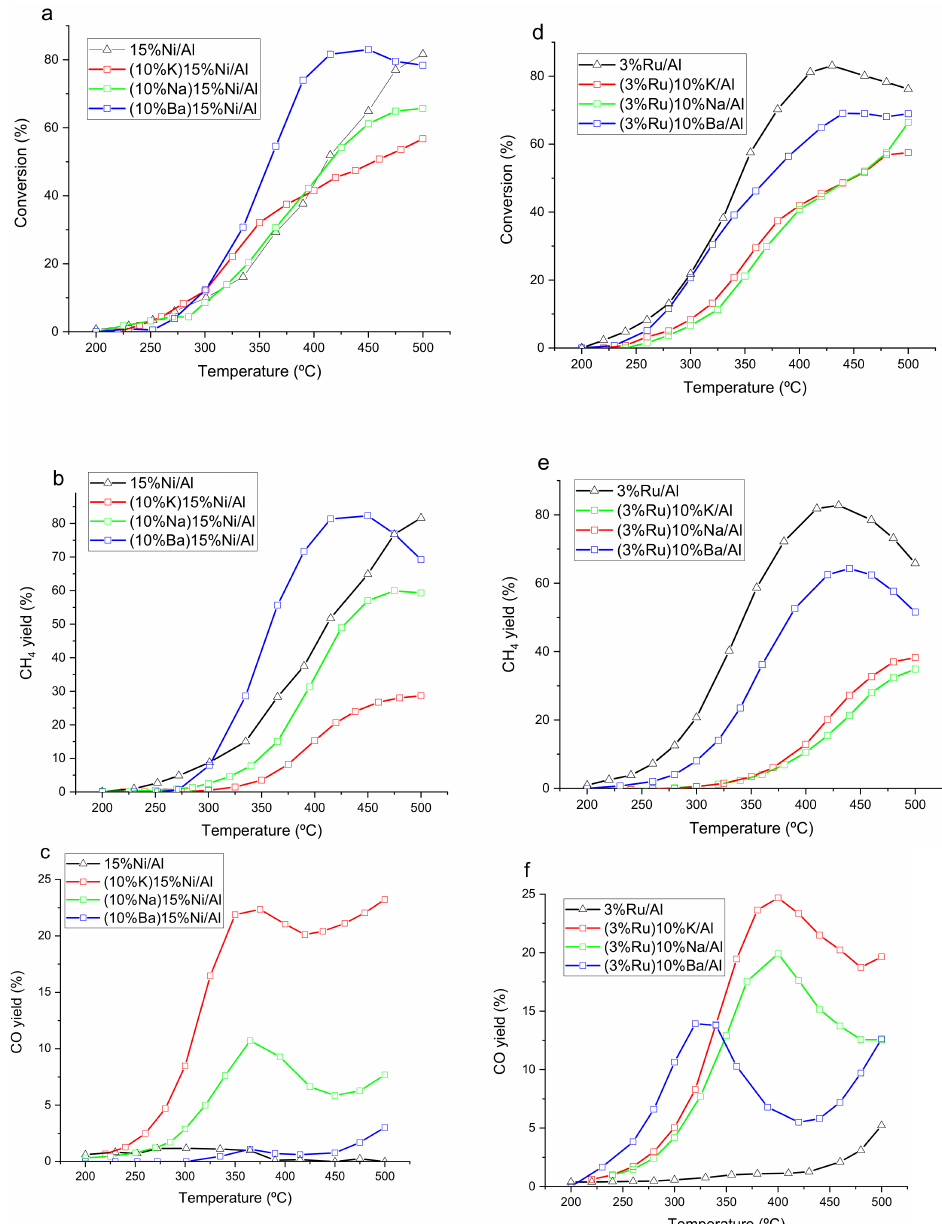
Figure 1. CO 2 conversion, CH 4 and CO yield for catalyst based on Ni ( a – c ) and Ru ( d – f ) without alkaline metal and with three alkaline metals (K, Na,